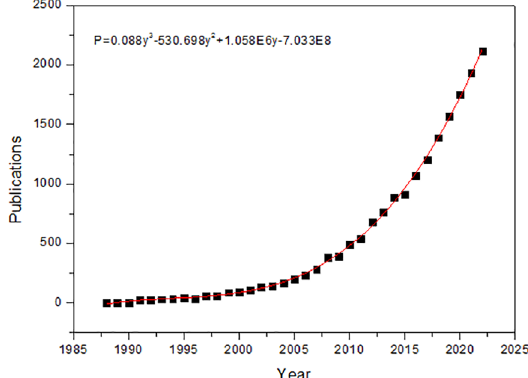
Figure 1. Publications related to the keyword “natural fiber composite” generated by the ISI Web of Science